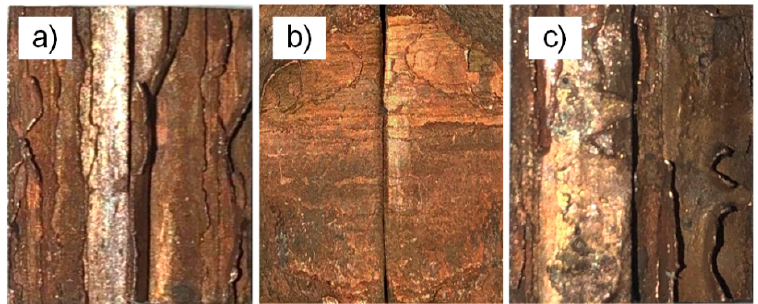
Figure 8. Macro-morphology fracture surface of tensile specimen ( a ) for specimen 1; ( b ) for specimen 2; and, ( c ) for specimen 3; steel on the left and copper on the right.